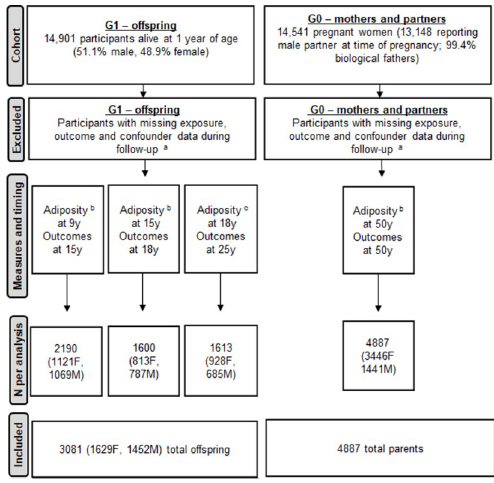
Fig 1. Flow diagram of study design. a Participants lost to follow-up or did not have complete data required for analyses. b Includes BMI, fat mass, and waist circumference. c Only BMI and fat mass available at this time point. BMI, body mass index; F; female; G0, parent generation 0; G1, offspring generation 1; M, male.